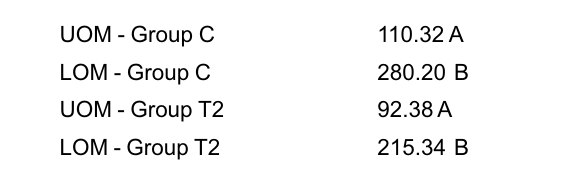
Different letters indicate statistically significant difference at 5%. UOM: Orbicularis oris muscle upper portion; LOM: Orbicularis oris muscle lower